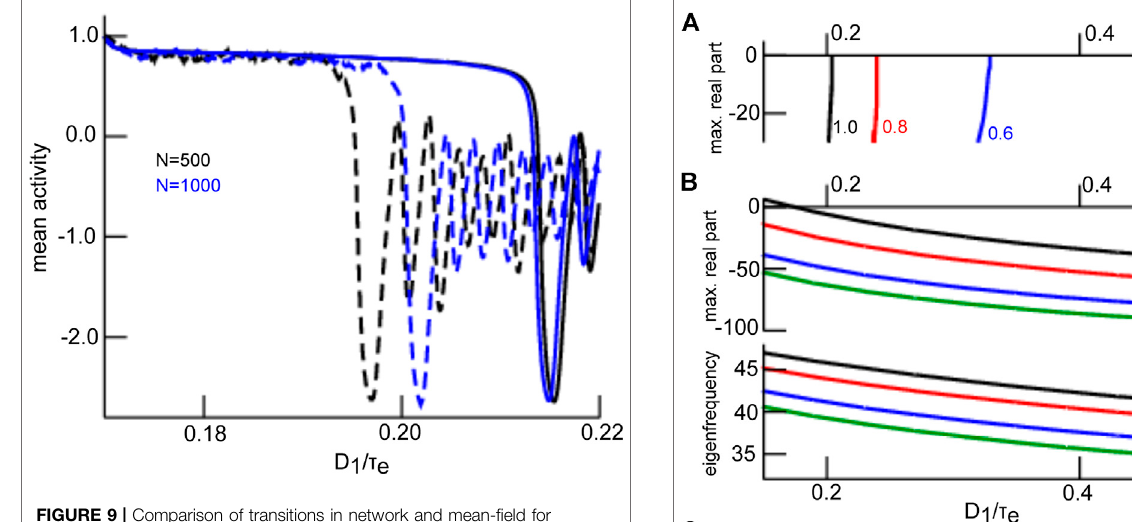
FIGURE 9 | Comparison of transitions in network and mean- fi eld for different network sizes. The network average (dashed line) and mean- fi eld solutions (solid line) resemble more for larger network size N . This is explained by reduced fi nite-size fl uctuations for larger networks. The initial value of the mean- fi eld activity has been chosen to the initial value of the network average. Simulations consider zero-mean Gaussian simulations with q (cid:1) 1.